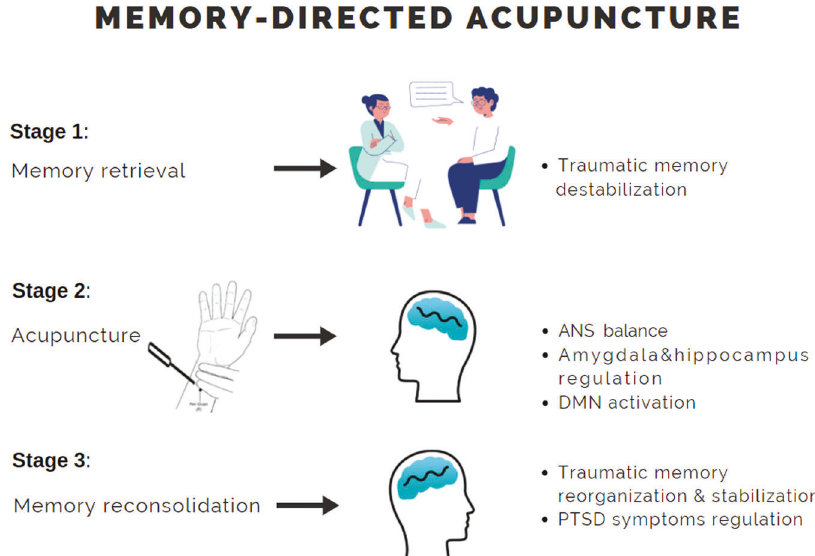
Fig. 1 A clinical model for memory-directed acupuncture. Stage 1 includes a therapeutic conversation between the therapist and the patient, in which the traumatic event is retrieved. Following this, in stage 2, an acupuncture session is applied. During stage 3, the targeted traumatic memory that has been evoked (stage 1) is reintegrated through the widespread effects of